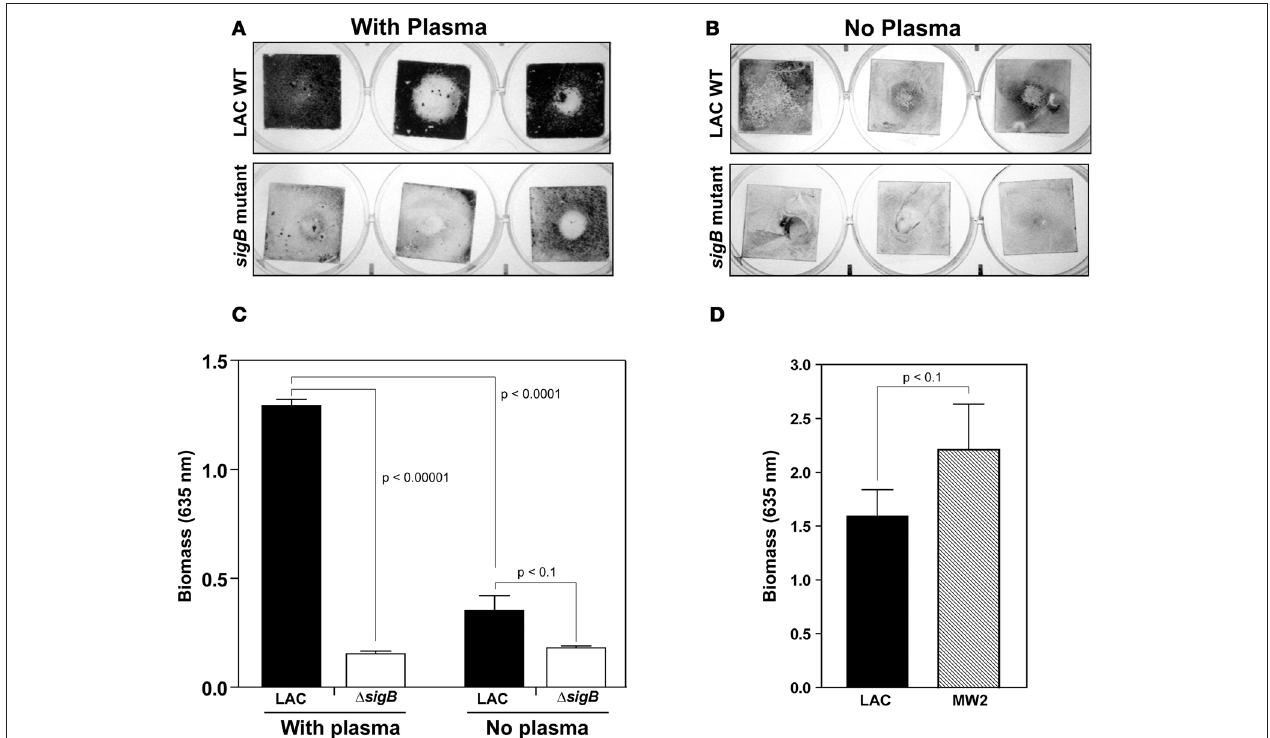
measured biomass for plasma-coated or untreated coverslip biofilms for LAC WT and (cid:2) sigB (C) or USA400 strain MW2 compared with LAC WT (D) . In both (C) and (D) , biomass was measured at OD 635 and P values were determined by students two-tailed T